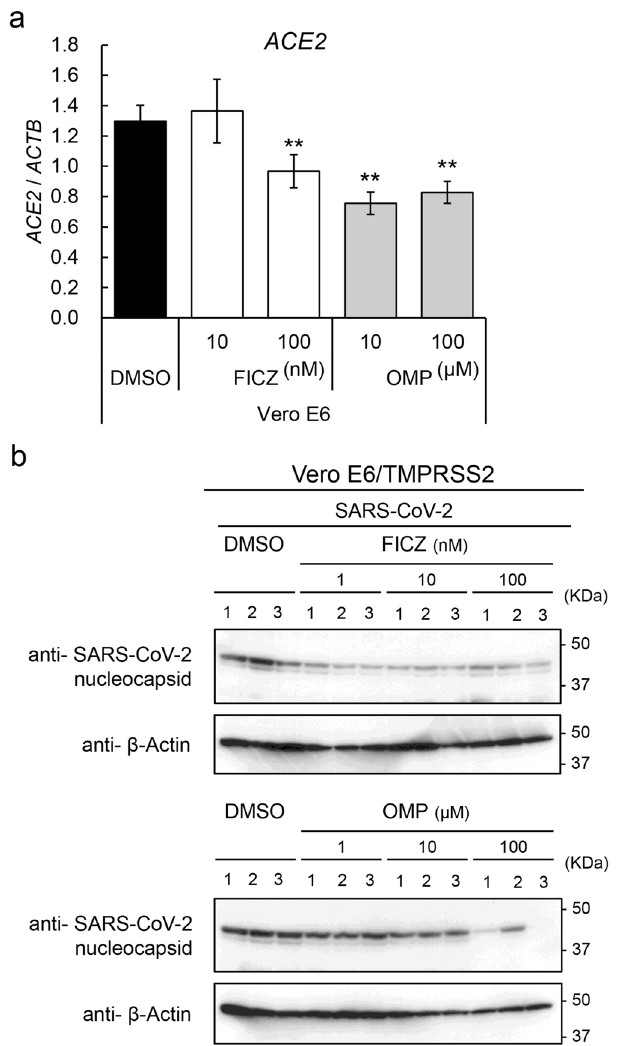
Figure 5. Effects of AHR agonists on SARS-CoV-2 infection to Vero E6 cells. ( a ) Expression level of ACE2 gene in FICZ or OMP treated TMPRSS2 transfected Vero E6 cells was evaluated by quantitative RT-PCR. Relative gene expression level was calculated by using ACTB expression as the denominator for each cell line (n = 3). For all quantitative values, the average and SD are shown. Statistical significance was calculated for the indicated paired samples with ** representing P < 0.01. ( b ) Intracellular amount of nucleocapsid protein of SARS-CoV-2 was evaluated with immunoblotting analysis (n = 3). A representative result is